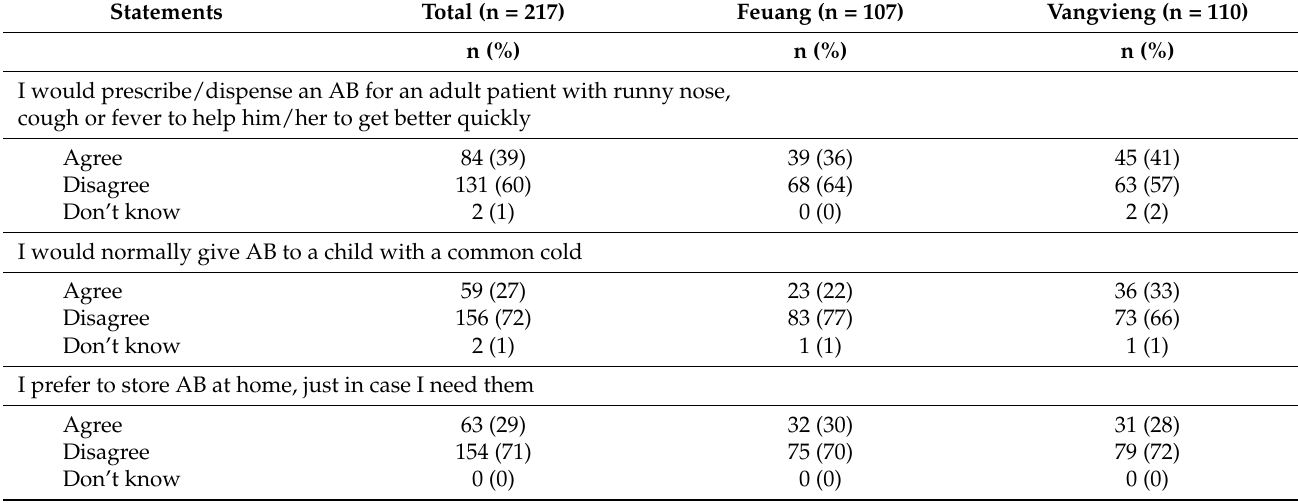
Table 3. Attitudes of participants towards antibiotic use and